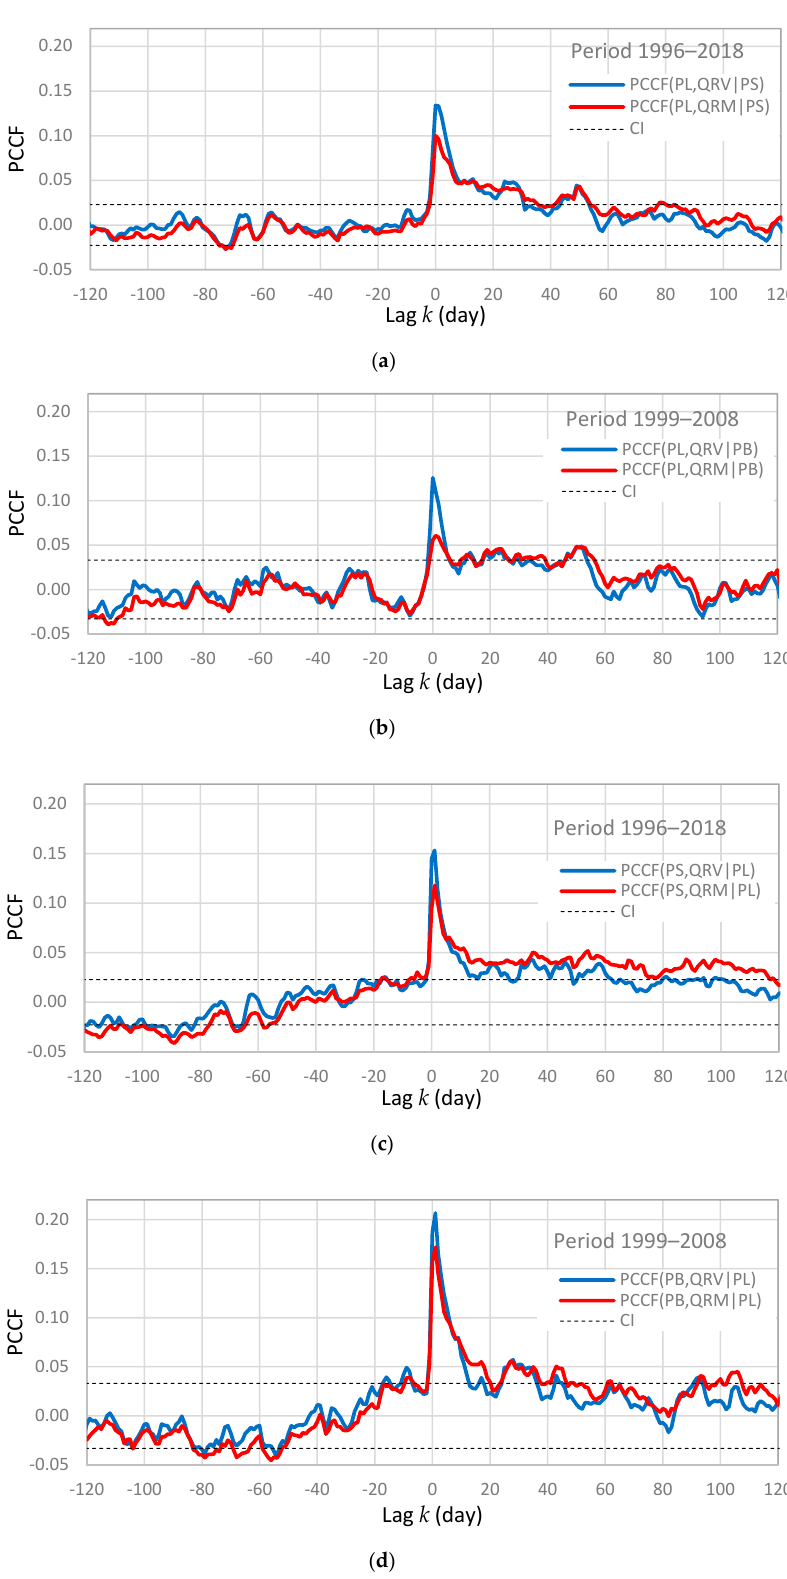
Figure 7. Partial cross-correlation function (PCCF) for the input time series of rainfall from MS Livno (P L ), where the control time series is: ( a ) rainfall from MS Sinj (P S ) and ( b ) rainfall from RG Biteli ć Donji (P B ). PCCF for the control time series of rainfall P L , where the input time series is: ( c ) rainfall P S , and ( d ) rainfall P B . The output time series is discharge from the springs Rumin Mali (Q RM ) and Rumin Veliki (Q RV ). CI—confidence interval.